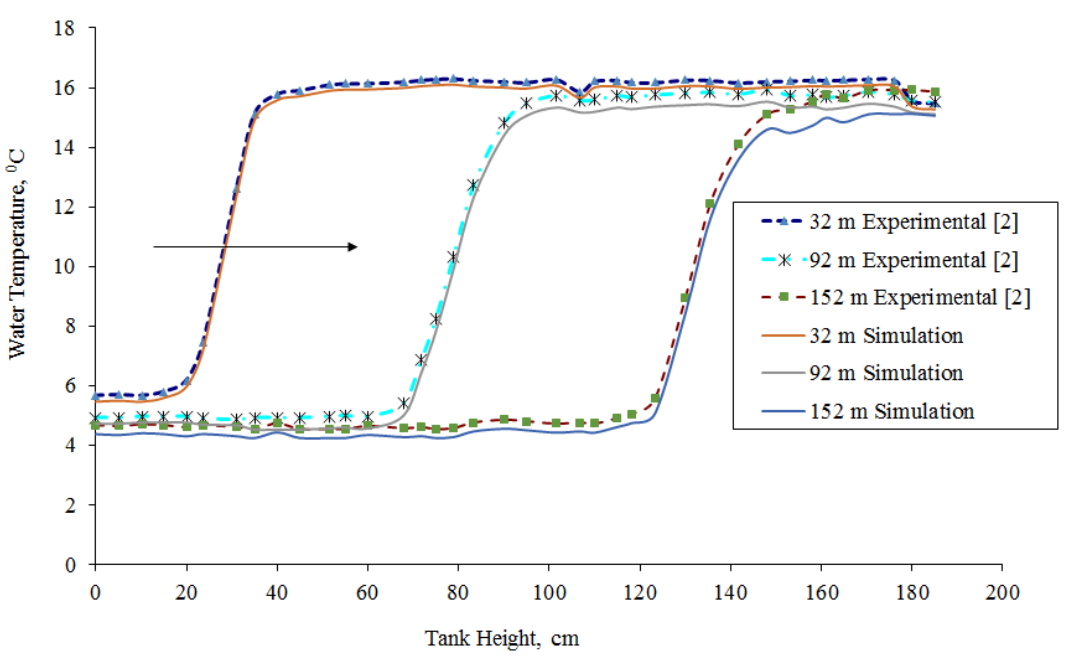
Figure 5. Variation of the temperature profile in a chilled water storage tank: predicted and measured values [2].